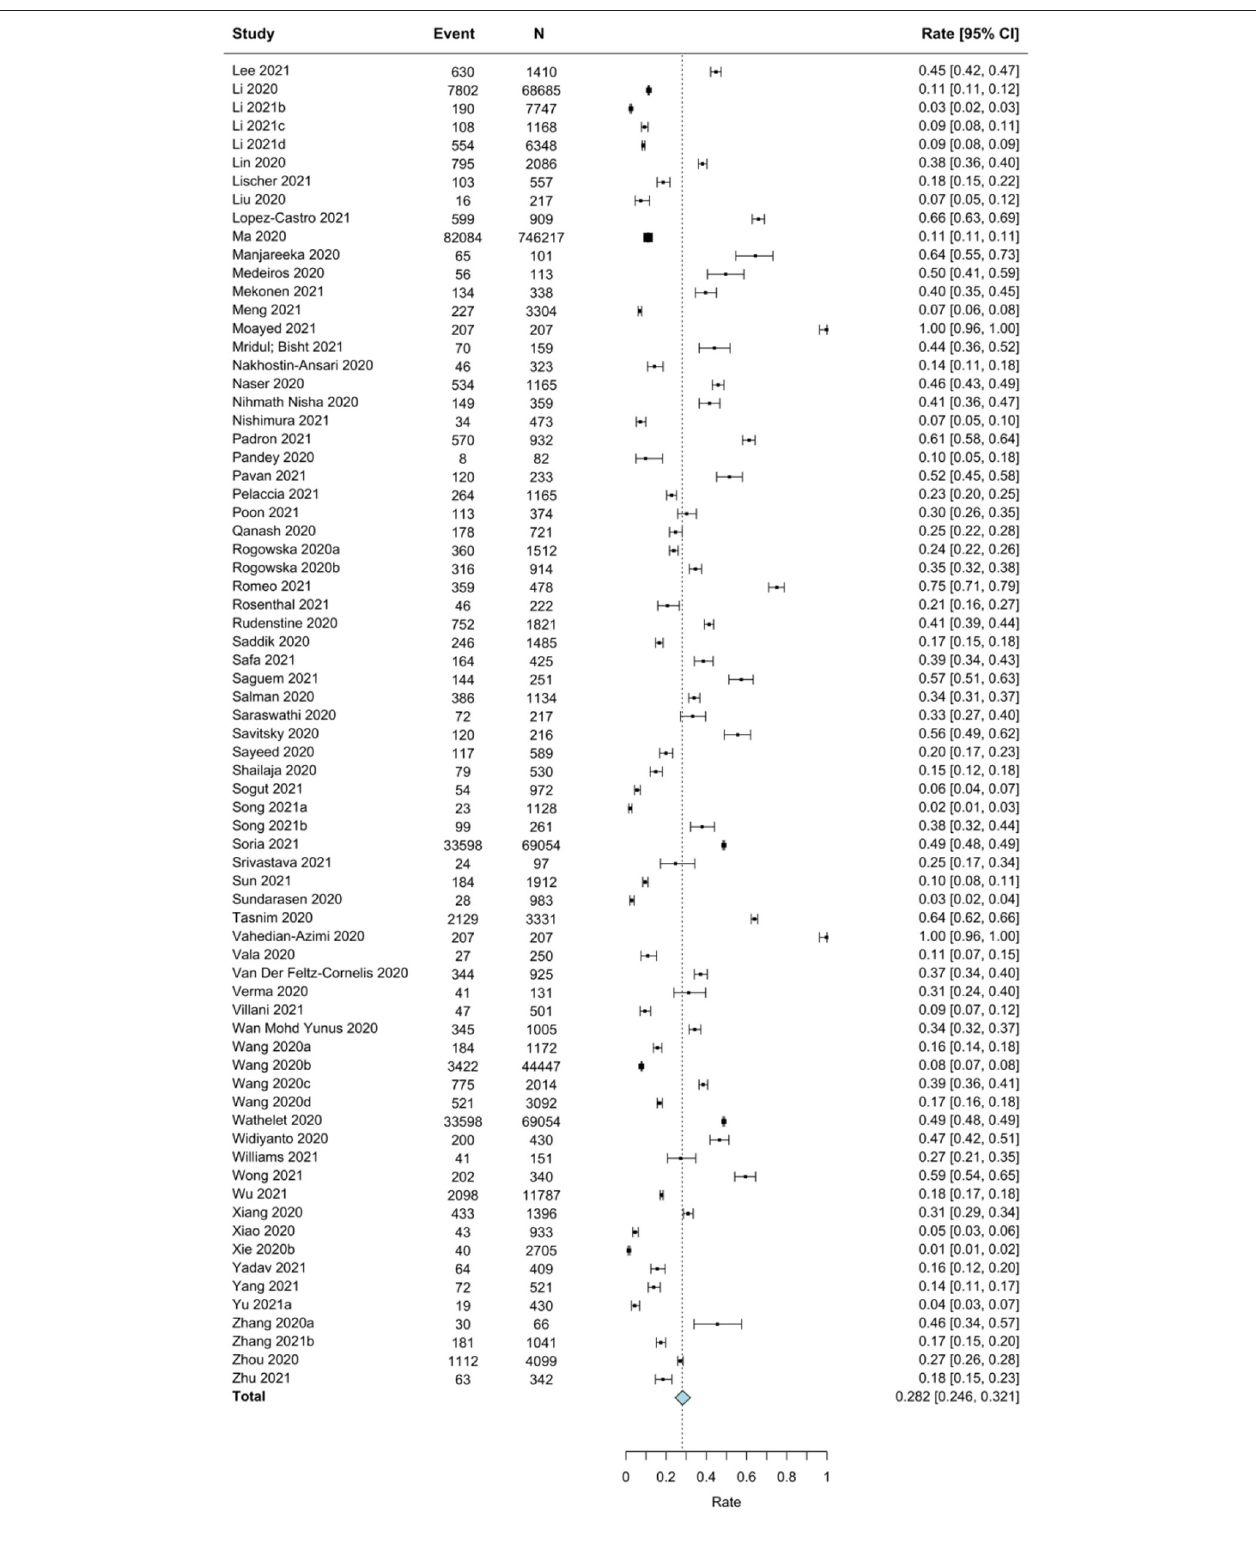
Frontiers in Psychiatry |